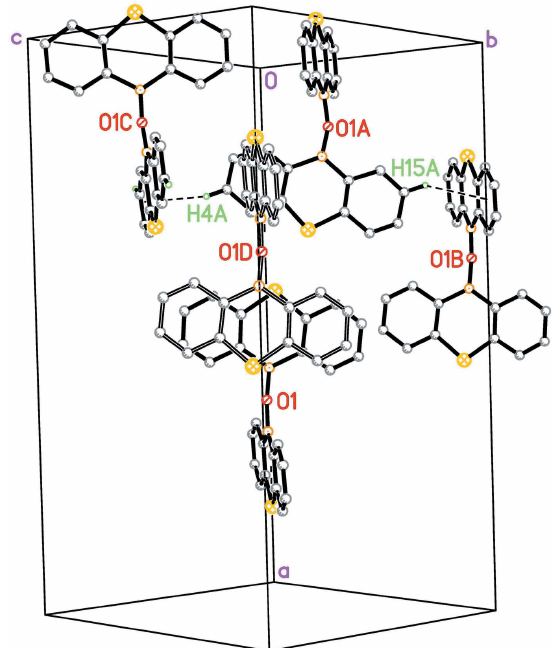
Figure 8 Partial packing diagram of (II). The molecules containing O1 and O1 A are the two symmetry-independent molecules in the asymmetric unit. The molecule containing O1 B was generated by the symmetry operator x , 1 (cid:4) y , 1 + z , that containing O1 C by the symmetry operator 1 (cid:4) x , 1 (cid:4) y , 2 2 (cid:4) z and that containing O1 D by the symmetry operator 1 (cid:4) x , 1 (cid:4) y , 1 (cid:4) z . This molecule is drawn with open bonds in order to show the (cid:2) – (cid:2) interaction. Only the H atoms involved in a C—H (cid:3)(cid:3)(cid:3) (cid:2) interaction are shown and Acta Cryst. (2019). E 75 , 690–694